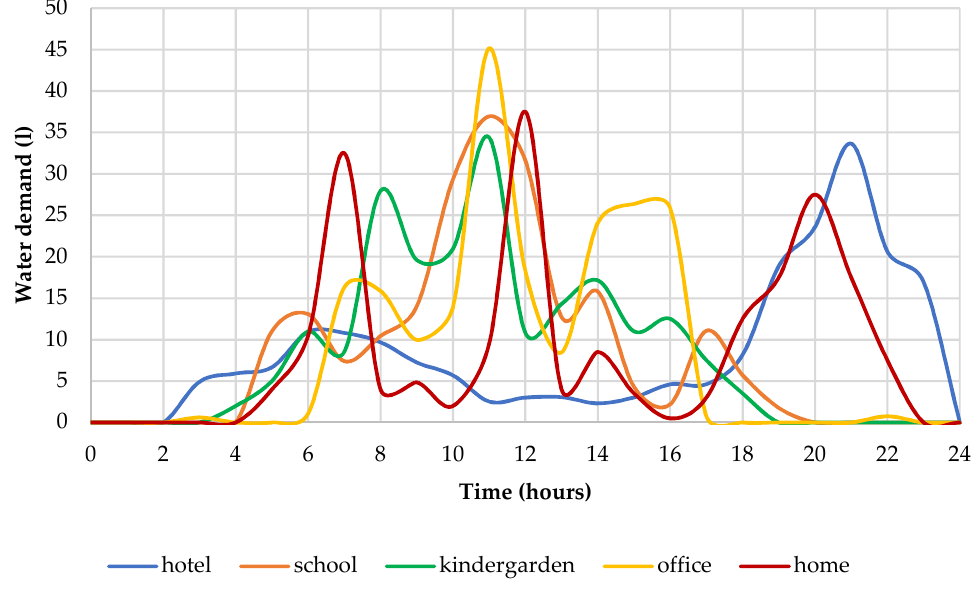
Figure 12. DHW demand curves for various buildings.